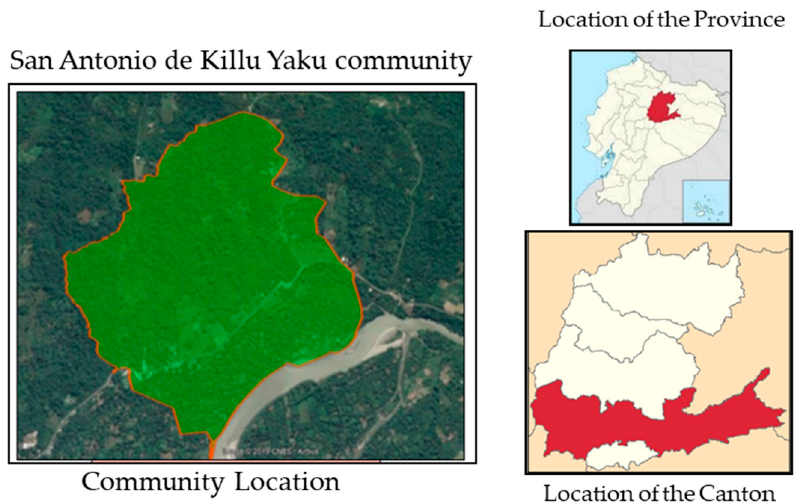
Figure 1. Map of the location of the San Antonio de Killu Yaku community.